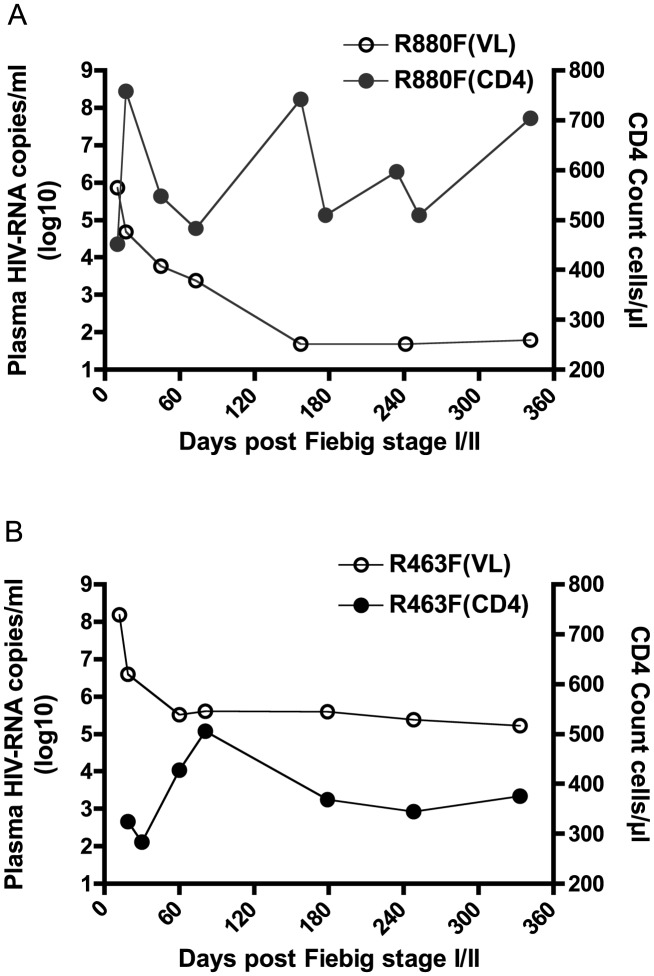
Plasma viral load and CD4 count in the two recipients during the first year of infection.Plasma viral load in RNA copies/ml is plotted on a log10 scale along the left vertical axis, while the CD4 T cell count in cells/µl is plotted along the right vertical axis. Time is indicated along the horizontal axis as days post-Fiebig Stage I/II in each recipient. The solid circles represent the longitudinal CD4 counts; the open circles represent plasma viral load. (A) HIV-1 elite controller R880F (B) HIV-1 rapid progressor R463F.